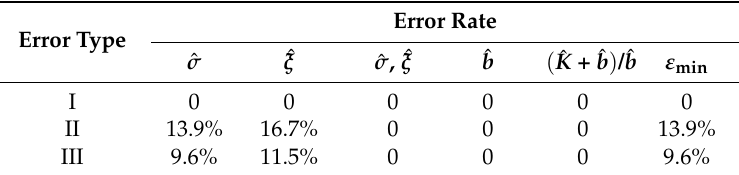
Table 2. Elimination of false matches experiment